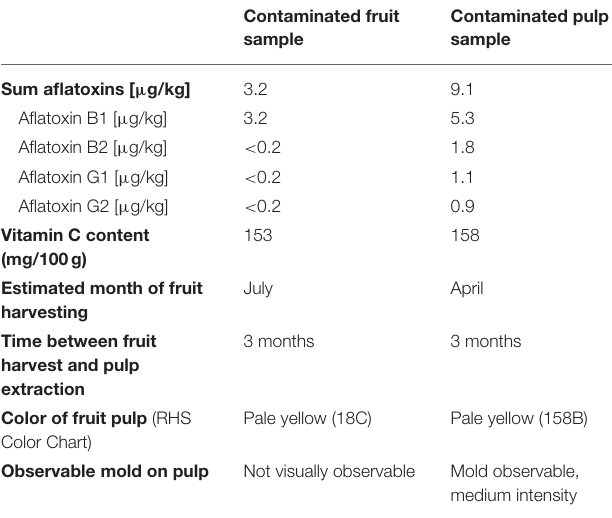
TABLE 3 | Characteristics of analyzed baobab samples containing